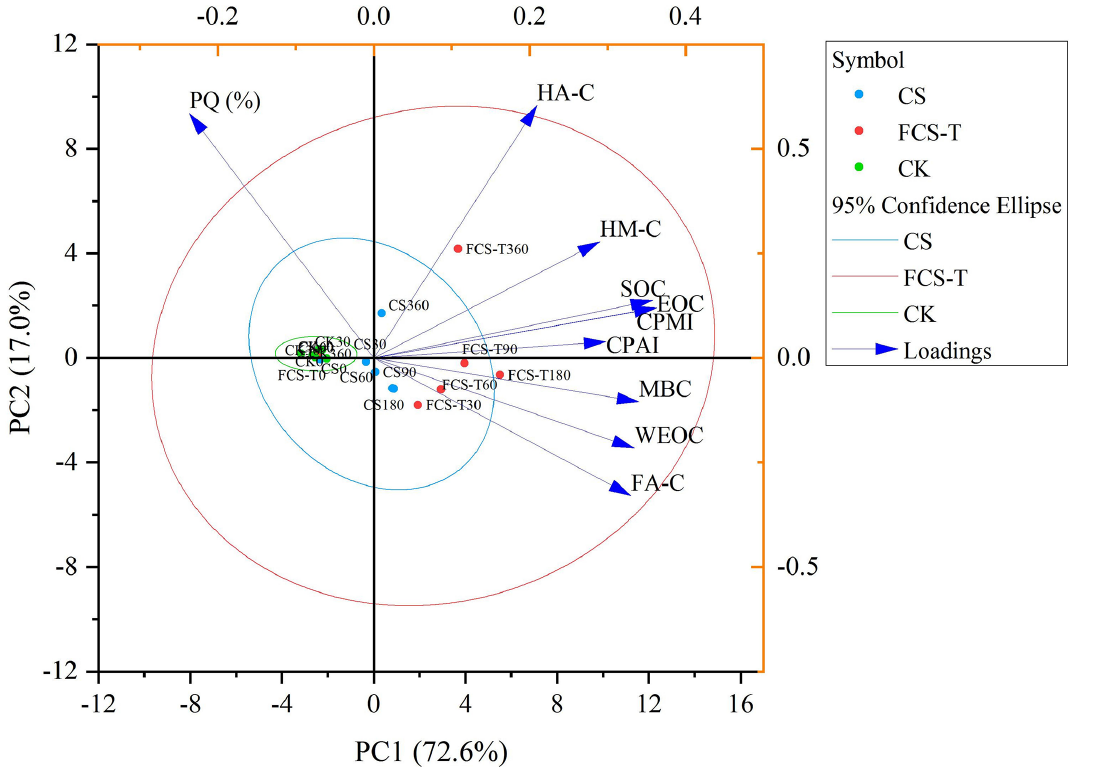
Figure 6. Principal component analysis (PCA) of soil organic carbon parameters and humus components affected by different treatments during 360d of the experiment. PC, principal component; SOC, soil organic carbon; CPMI, carbon pool management index; CPAI, carbon pool activity index; WEOC, water-extractable organic carbon; EOC, easily oxidizable organic carbon; MBC, microbial biomass carbon; HA, humic acid; FA, fulvic acid; HM, humin; PQ, humification degree; CS, corn straw returned to the field; FCS-T, fermented corn straw treated with T. reesei returned to the field; CK, blank control